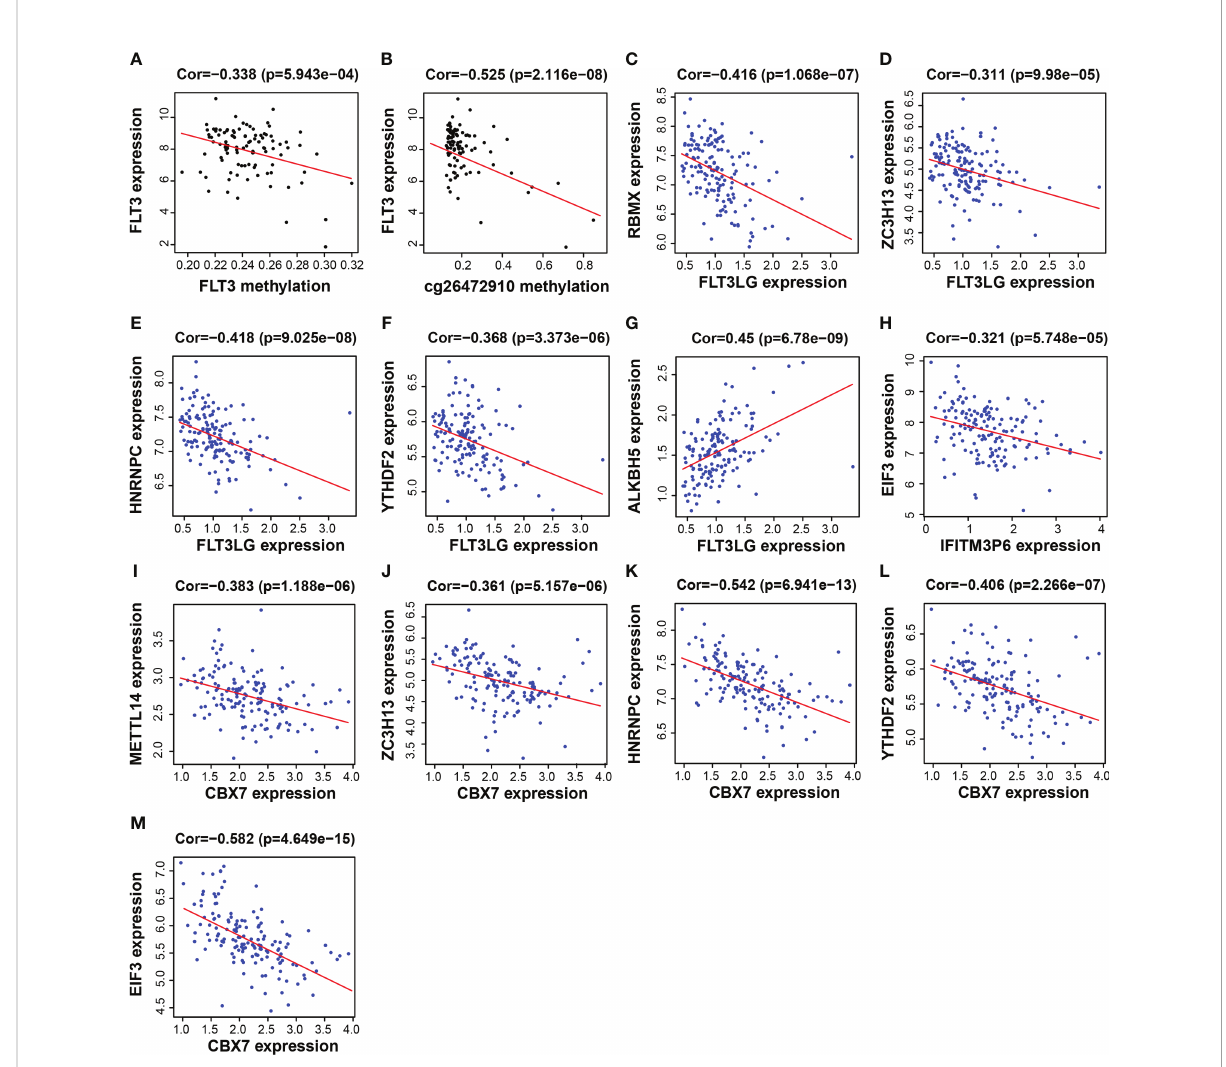
FIGURE 8 Functional mechanism analysis for FLT3LG, IFITM3P6 and CBX7. (A, B) Relationship between FLT3 DNA methylation and FLT3 expression and the main methylation site. (C – G) Relationship between FLT3LG expression and N 6 -methyladenosine (m6A) methylation-related gene expression. (H) Relationship between IFITM3P6 expression and m6A methylation-related gene expression. (I – M) Relationship between CBX7 expression and m6A methylation-related gene